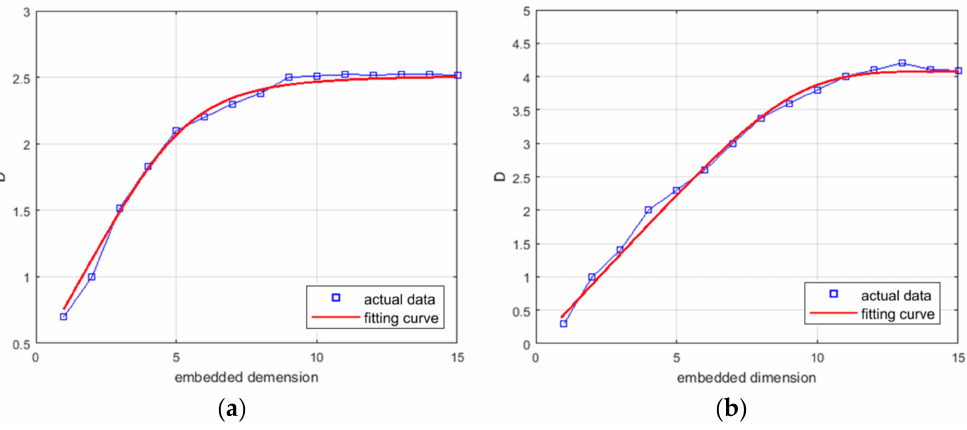
Figure 10. Correlation dimension. ( a ) Spatial domain. ( b ) Temporal